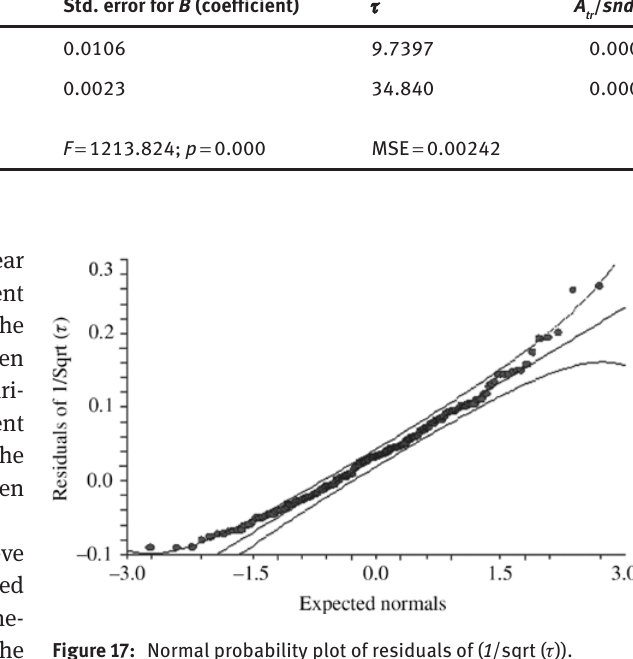
Figure 17: Normal probability plot of residuals of ( 1 /sqrt ( τ